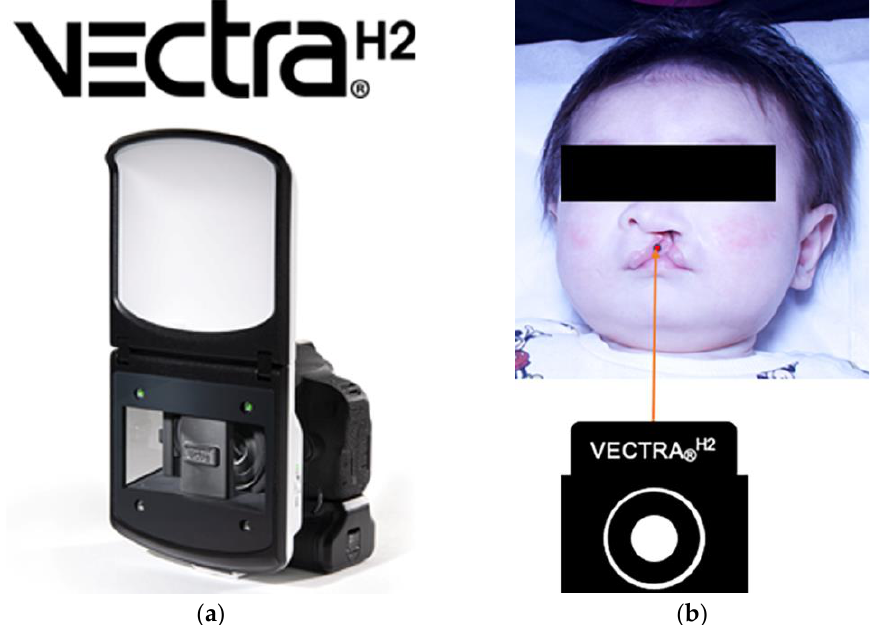
Figure 1. ( a ) Vectra H2 3D analyzer (Integral Corporation, Tokyo, Japan). ( b ). Distance between subject and 3D analyzer.